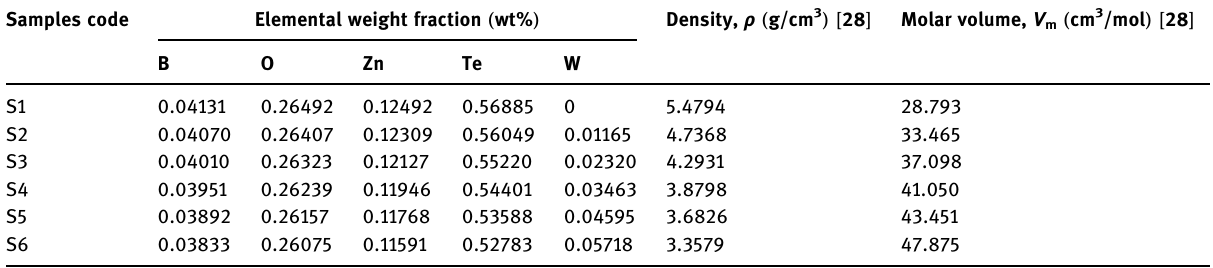
Table 1: Samples code, elemental weight fraction, density, and molar volume of ( 1 − x )[ 0.7TeO 2 – 0.3B 2 O 3 – 0.3ZnO ] − x WO 3 ( x = 0.00, 0.01, 0.02, 0.03, 0.04 and 0.05 mol% glasses ) Samples